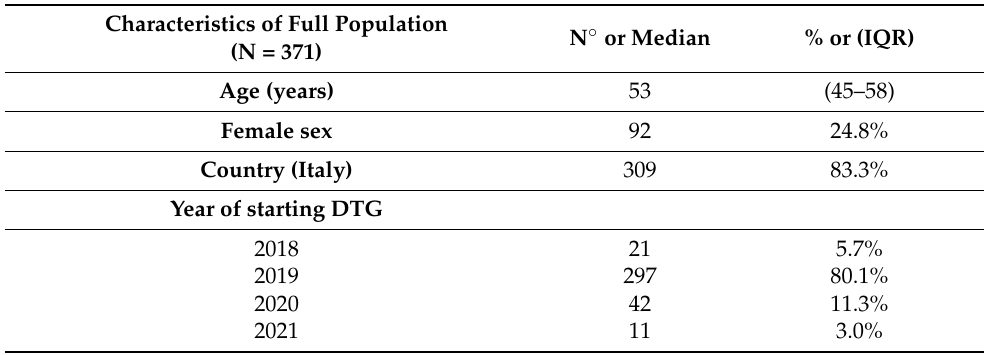
Table 1. Characteristics of the full study